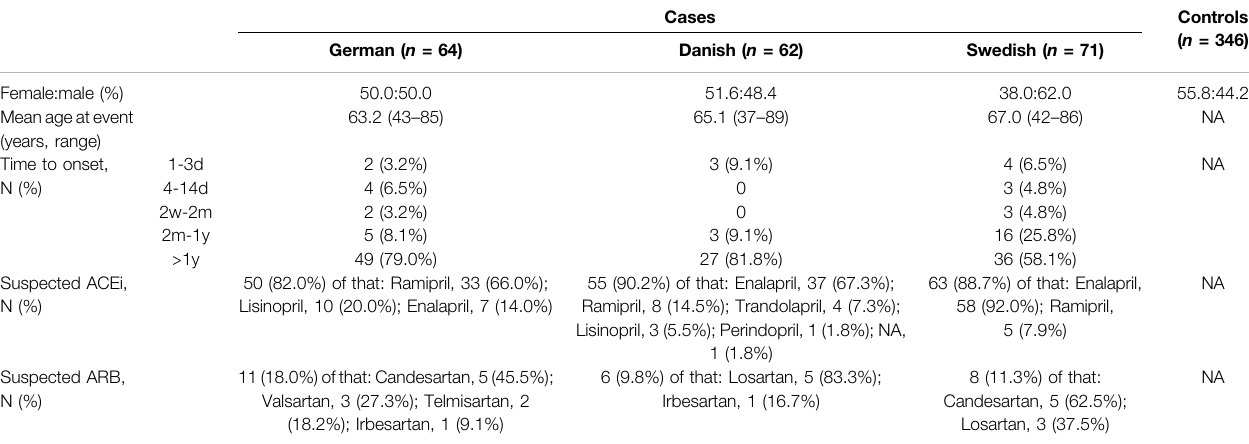
TABLE 1 | Baseline characteristics of the fi nal study